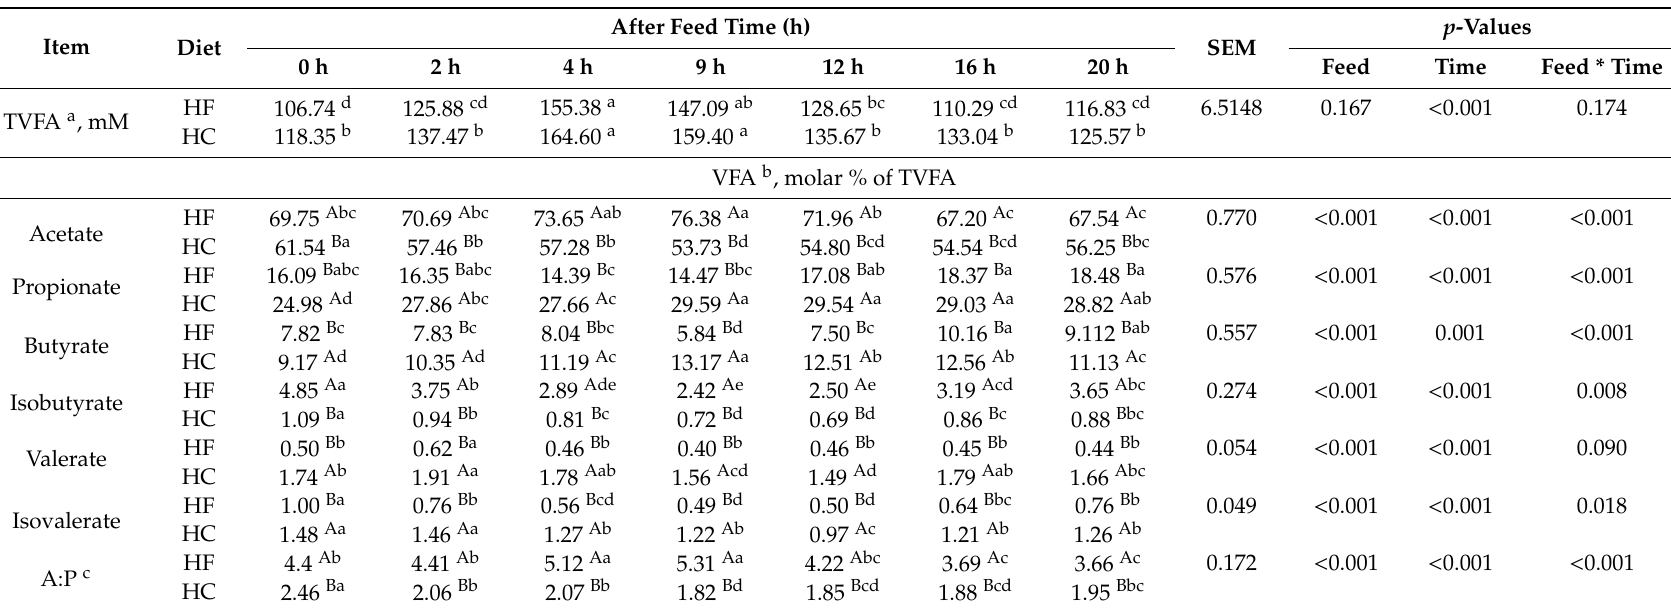
Table 2. Rumen fermentation parameters over the course of a feeding cycle in dairy cows receiving two diets: HF and